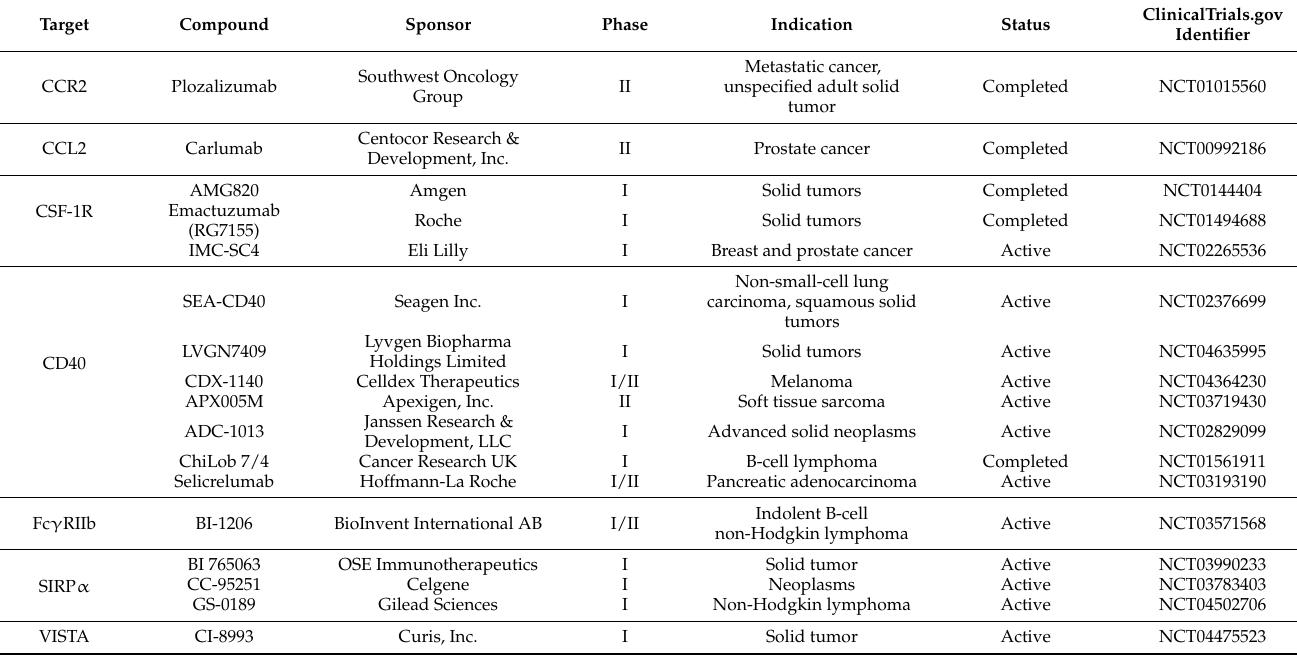
Table 1. TAM-targeting mAbs in completed or active trials. These mAbs have been investigated in or are in active clinical trials, either as single agents, or in combination with chemotherapeutic agents, checkpoint inhibitors, Fc fusion proteins or TLR